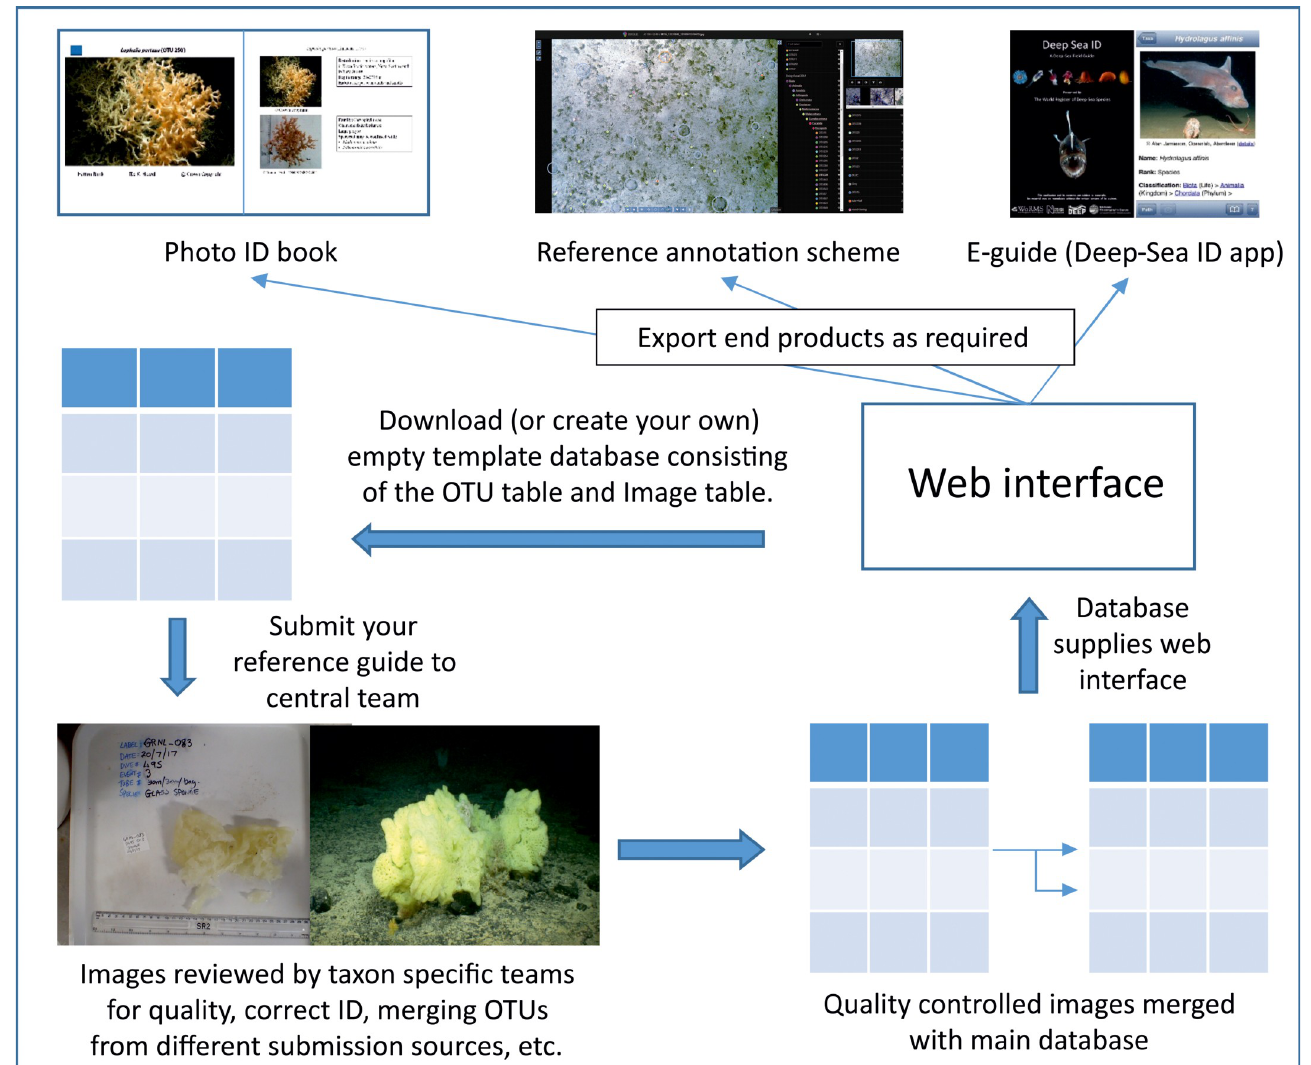
Fig 2. A conceptual model for how the developed framework will